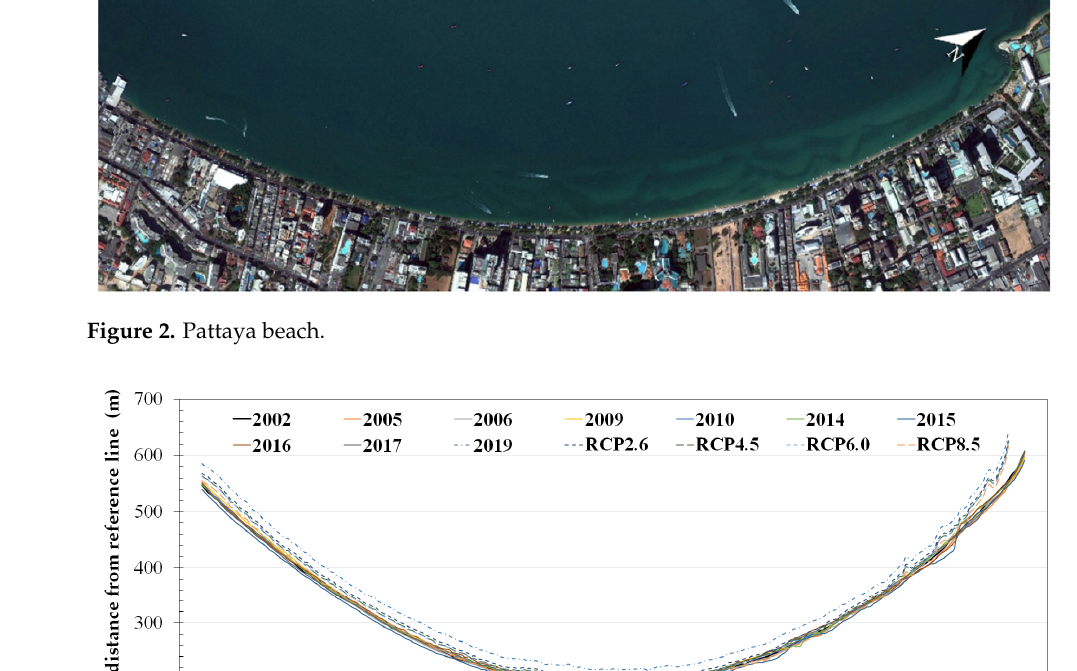
Figure 3. Shoreline position of Pattaya beach.